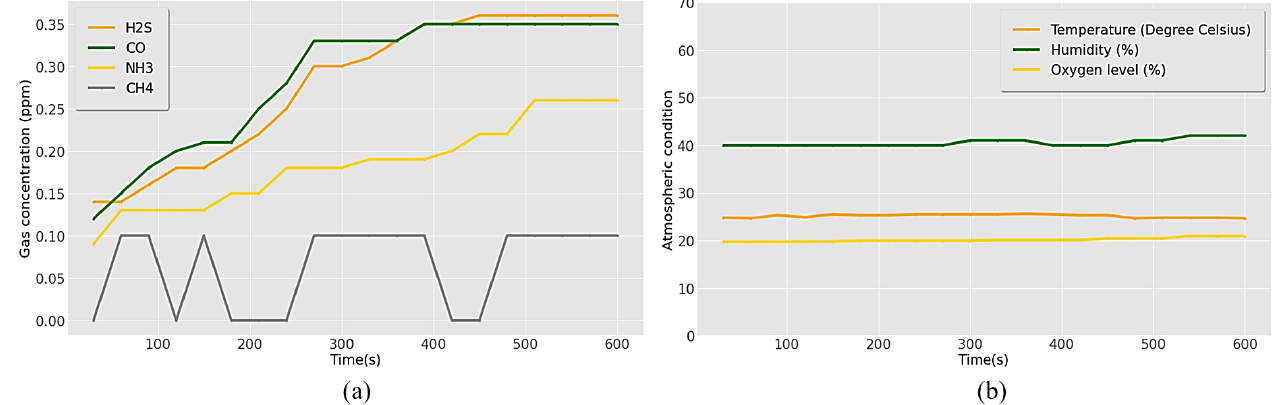
Figure 11. Recorded results for ( a ) concentration of toxic gases and ( b ) atmospheric parameters in the normal environment.